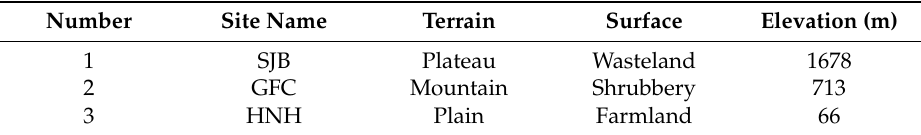
Table 5. Wind tower site information.